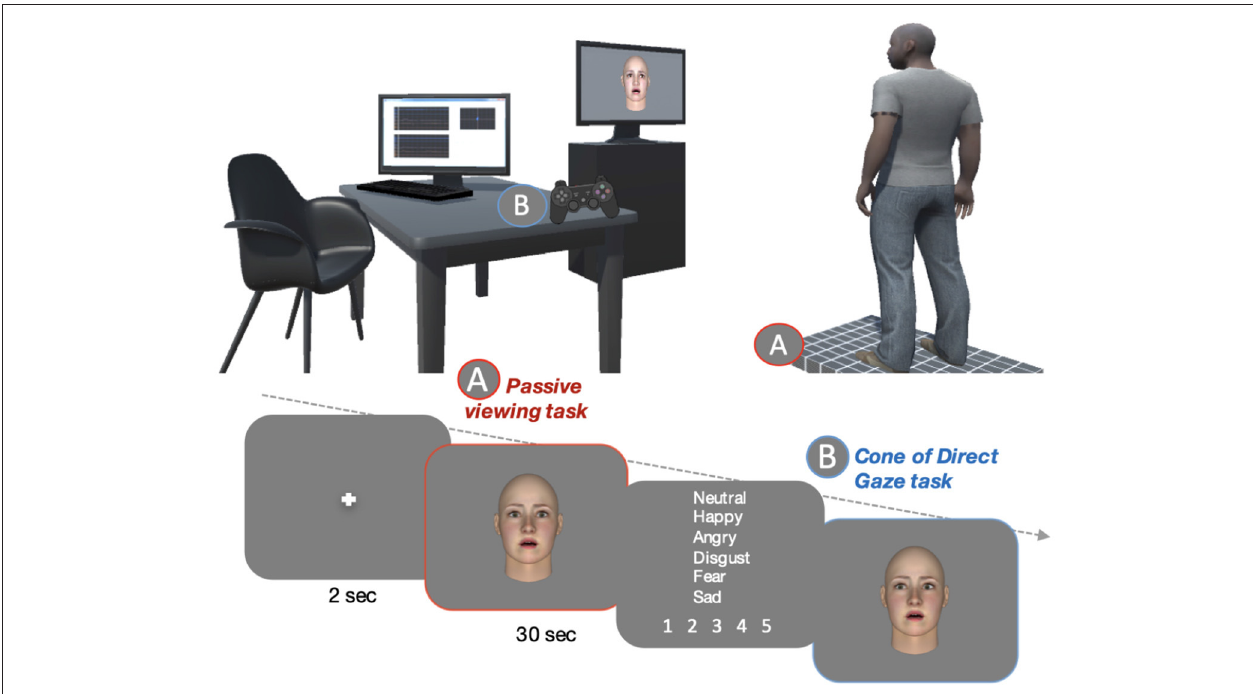
FIGURE 1 | Schematic representation of the experimental tasks: postural passive task during viewing of emotional faces on the force platform (A) Gaze categorization using the joystick (B) . The dotted arrow indicates the flow of time.